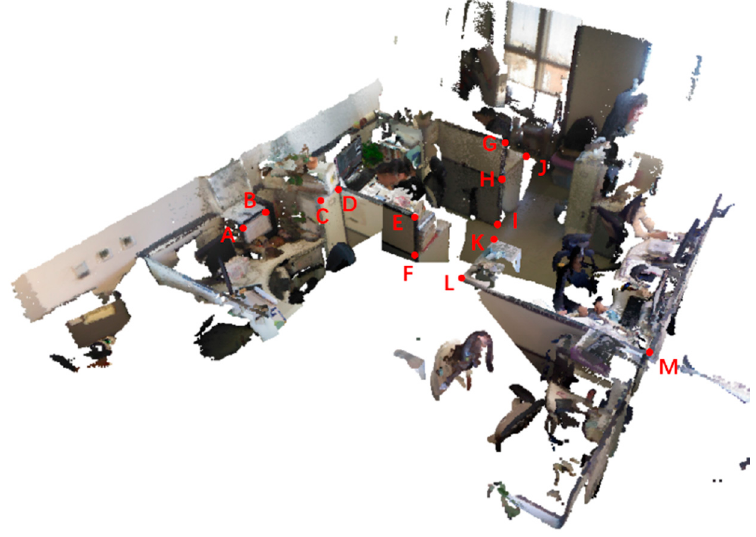
Figure 8. 3D reconstruction result by our method and the measured points. A–M are the end points of line segments. Table 2. Comparison between the actual lengths of seven line segments with the lengths measured in the reconstructed